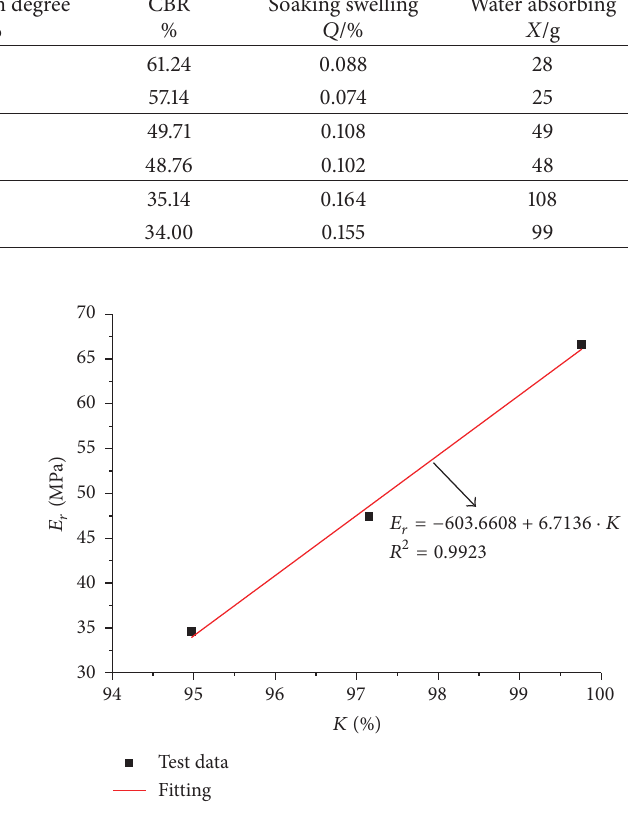
Figure 7: Relation between resilient modulus 𝐸 𝑟 and compaction degree K